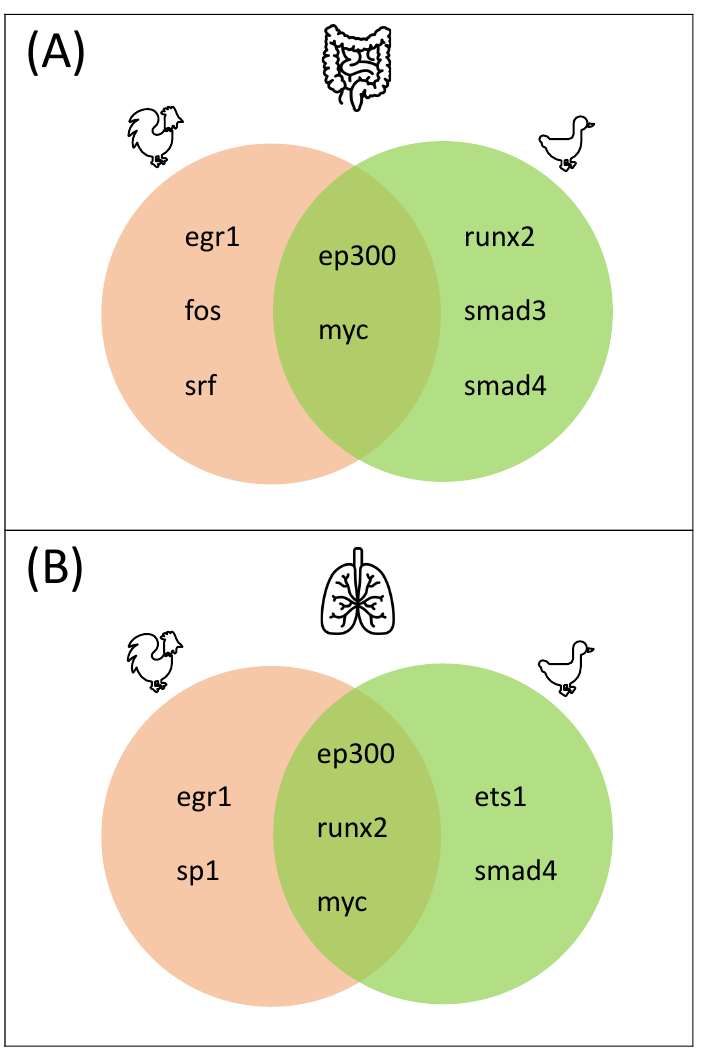
Figure 5. Common and species-specific master regulators for the ( A ) ileum and ( B ) lung tissue regulating the TF-TF